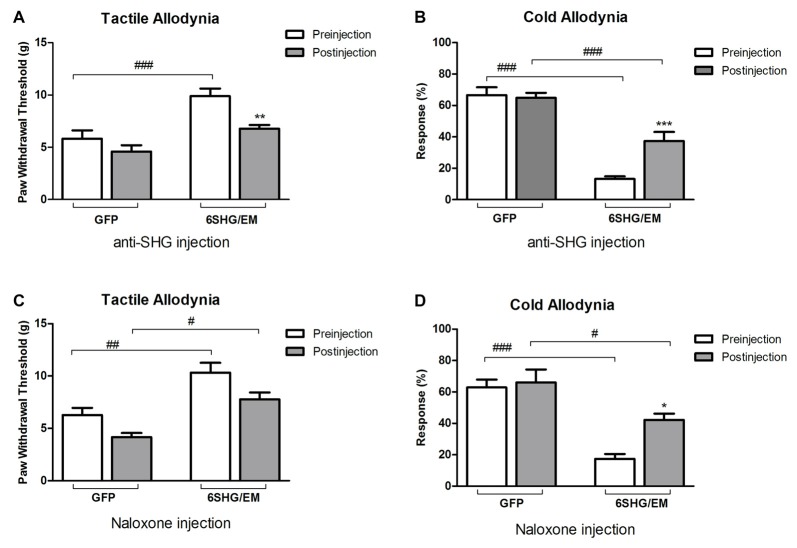
Pharmacological attenuation of the 6SHG/EM1 analgesic effect. Intrathecal injection of anti-SHG (5 mg/ml; A,B) and naloxone (0.1 mg/ml; C,D) in SCI animals 8 weeks post treatment (12 weeks post injury) reduced the observed effect in the treated animals. Anti SHG reversed both tactile and cold allodynia attenuation; naloxone was effective in reversing cold allodynia (*p < 0.05, **p < 0.01, ***p < 0.001 vs. preinjection; #p < 0.05, ##p < 0.01, ###p < 0.001 vs. GFP).